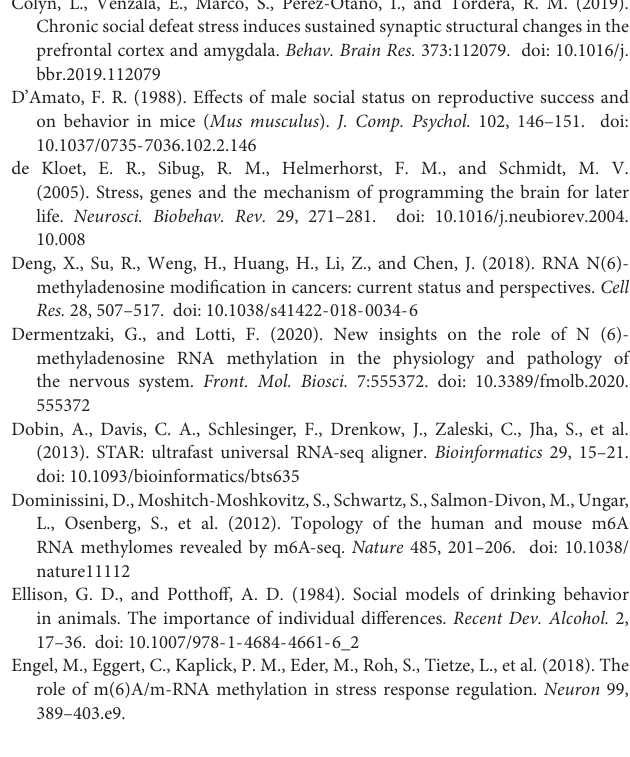
Supplementary Figure 1 | Specificity of m6A mRNA modification measurement. Supplementary Figure 2 | Uncropped Western blot image example. Supplementary Figure 3 | Methyltransferase activity assay with Sinefungin as inhibitor. Supplementary Table 1 | Differentially expressed genes in the right brain hemispheres of dominant versus submissive female